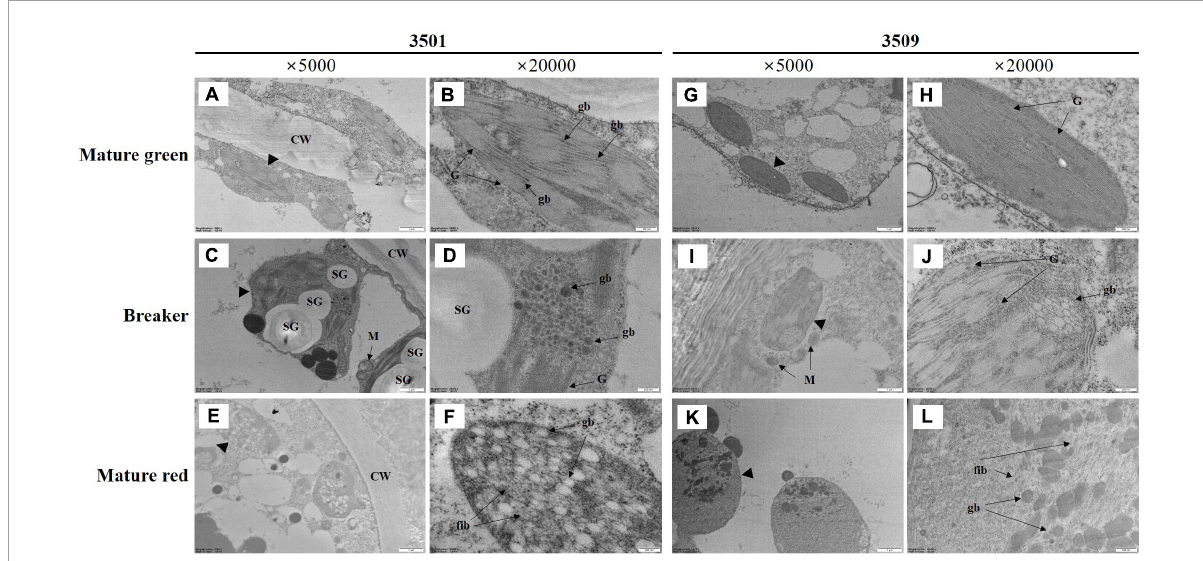
FIGURE2 Transmission electron microscopy (TEM) image of plastids in mature green (A,B,G,H) , breaker stage (C,D,I,J) , and mature red (E,F,K,L) fruit in “3501” and “3509.” The second and fourth columns are enlarged images of the first and third columns. CW, cell wall, G, granum, gb, plastoglobuli, SG, starch granule, M, mitochondria, fib, fibrils.